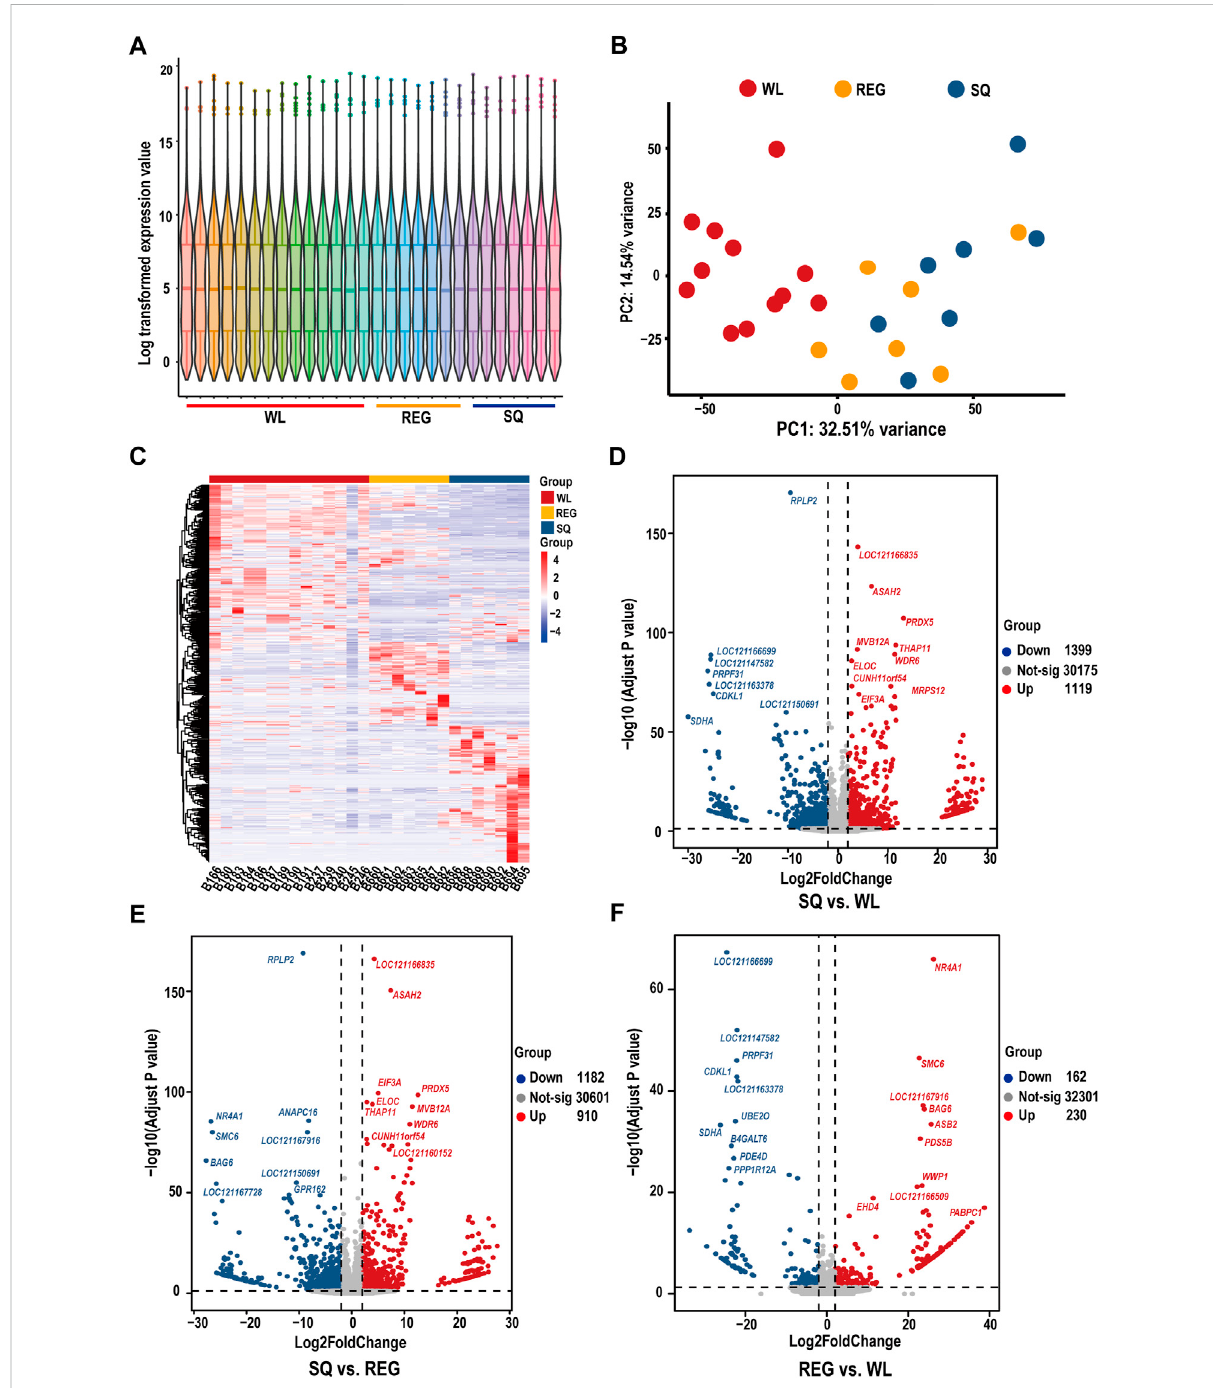
FIGURE 2 Expression levels, principal component analysis, differential gene expression heatmap and pair-to-pair-differential gene analysis based on the heart transcriptome of pikas. (A) Violin diagram of gene expression levels in the 28 samples. (B) PCA of the expression data of heart tissue samples from three populations of pikas. WL indicates Gansu pikas collected at 2,693 m, REG refers to plateau pikas collected at 3,406 m, and SQ refers to plateau pikas collected at 4,347 m. (C) Heatmap of the top 1% of genes according to their expression levels in 28 samples. (D) Volcano plot of differentiallyexpressedgenesinSQvs.WL(notethetenmostexpressedgenes). (E) VolcanoplotofdifferentiallyexpressedgenesinSQvs.REG(note the ten most expressed genes). (F) Volcano plot of differentially expressed genes in REG vs. WL (note the ten most expressed